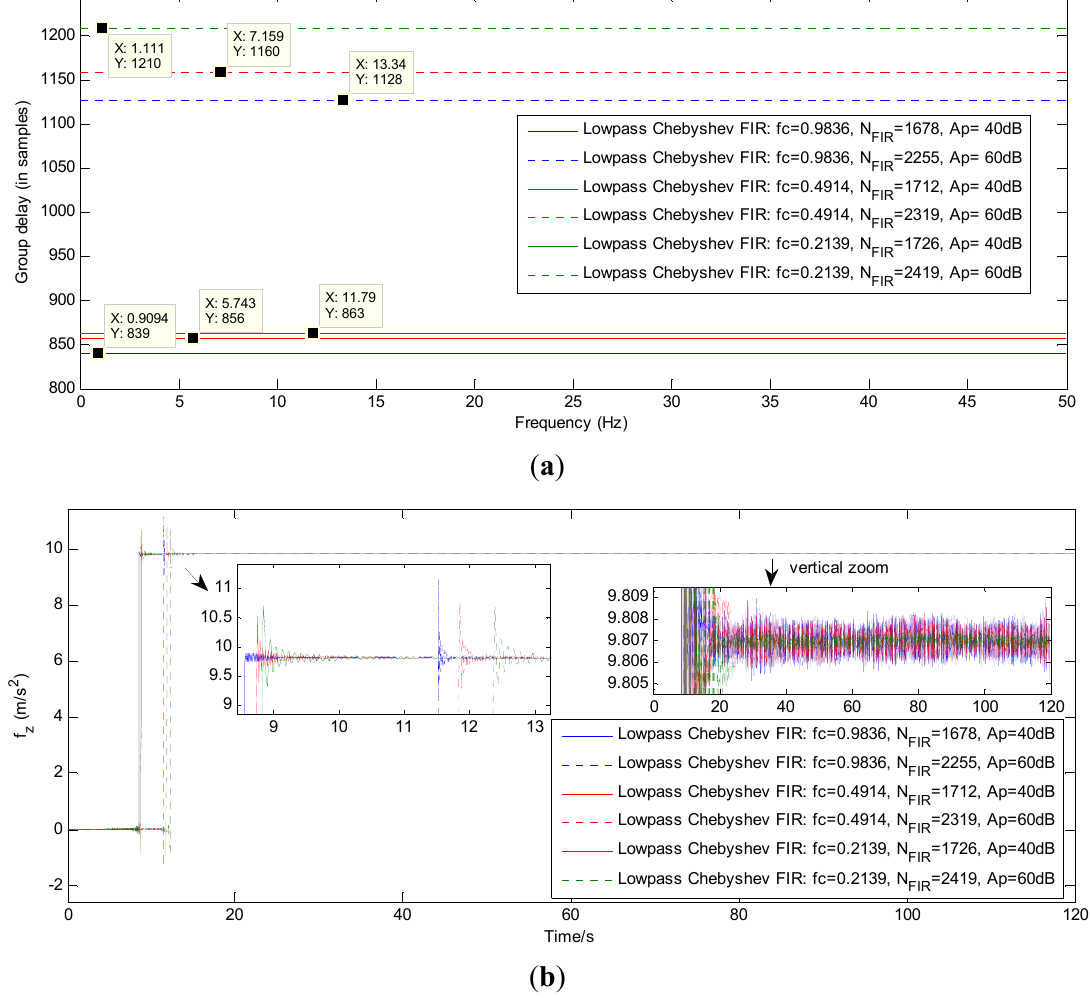
Figure 10. ( a ) Group time delay of FIR filters with different f frequencies; ( b ) FIR filtering results of the z axis acceleration with different f